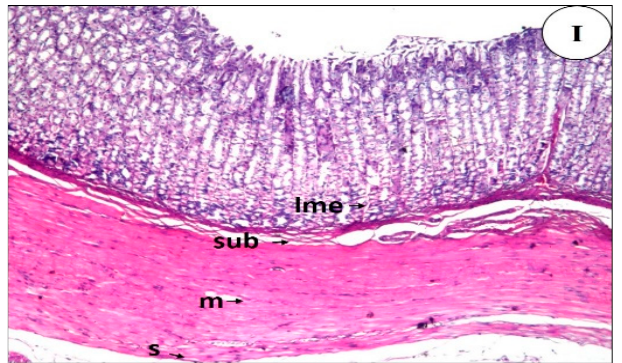
Figure 3. II-a. Showing focal necrosis (n) and desqua- mation of the lining mucosa of rat stomach, II-b: showing focal inflammatory cells infiltration (m) in submucosa and muscularis in indomethacin treated group (H&E × 16).